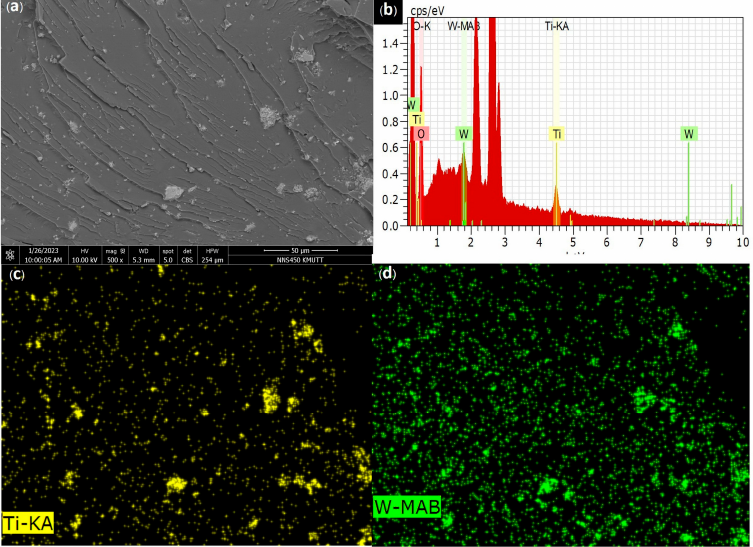
Figure 9. SEM image ( a ); EDX spectrum ( b ); and EDX dot maps ( c , d ) of polymer composite containing 10% ( w / v ) of the metal oxides (10%WO 3 @TiO 2 ).